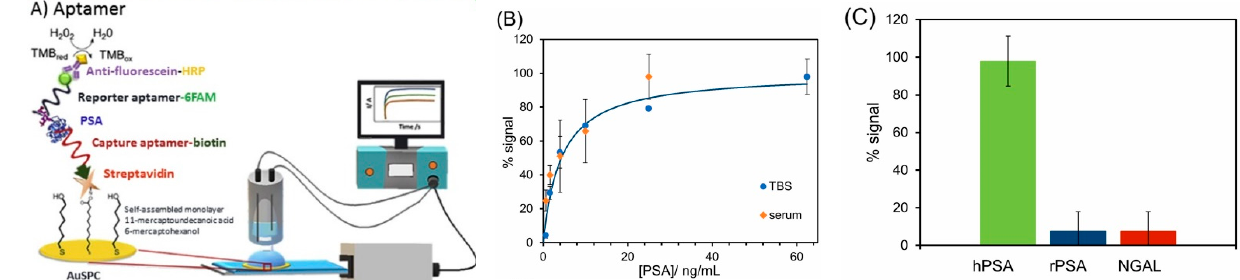
Figure 19. ( A ) Scheme of the sandwich assay; ( B ) calibration plots of PSA in buffer (TBS) and in diluted serum; and ( C ) sensor response to 25 ng mL − 1 of hPSA, rPSA and the glycoprotein lipocalin-2 (NGAL, used as a nonspecific probe). Reprinted from ref. [202], Copyright (2020) with permission from Elsevier and reprinted from ref. [200]. Copyright (2019) with permission from Elsevier.